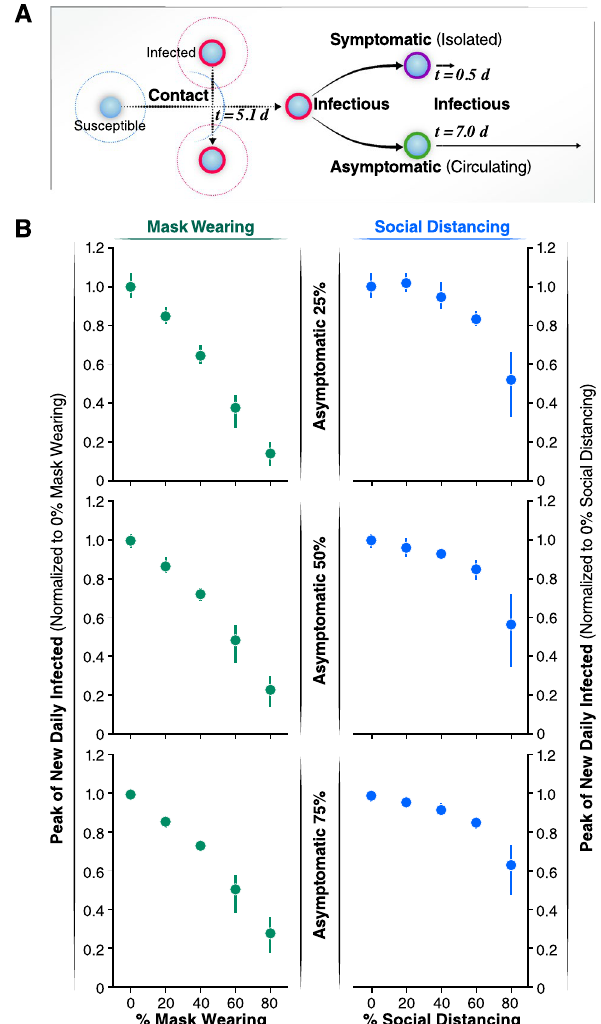
Figure 3. Effects of the asymptomatic population on the infected peak number. ( A ) Schematic representation of the asymptomatic transmission during the simulations. After 5.1 days of coming into contact with an infected individual, infectious agents can develop symptoms and after 12 h will be isolated. On the contrary, asymptomatic individuals don’t develop symptoms of the disease so they are not isolated but keep circulating thus contributing to spread the infection for 7 more days after the initial contact with an infectious agent. ( B ) The normalized peak of new daily infected is represented as a function of the percentage of the population wearing mask (left panels, green solid circles) and as a function of increasing the percentage of asymptomatic individuals (25% top left panel, 50% central left panel, 75% bottom left panel). The normalized peak of new daily infected is represented as a function of the percentage of the population practicing social distance (right panels, blue solid circles) and as a function of increasing the percentage of asymptomatic individuals (25% top right panel, 50% central right panel, 75% bottom right panel). Error bars represent 95% confidence intervals